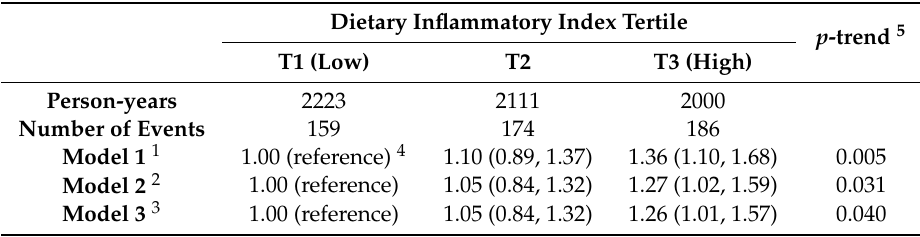
Table 2. Dietary inflammatory index and the composite outcome ( n =